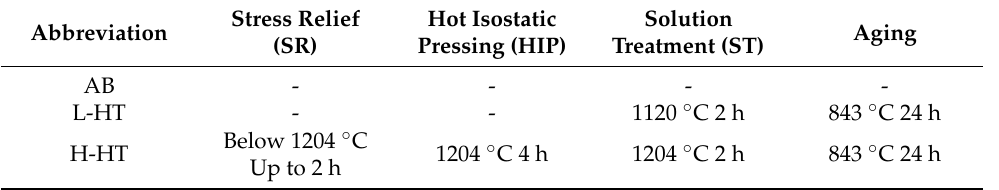
Table 2. Heat treatment conditions for IN738LC built